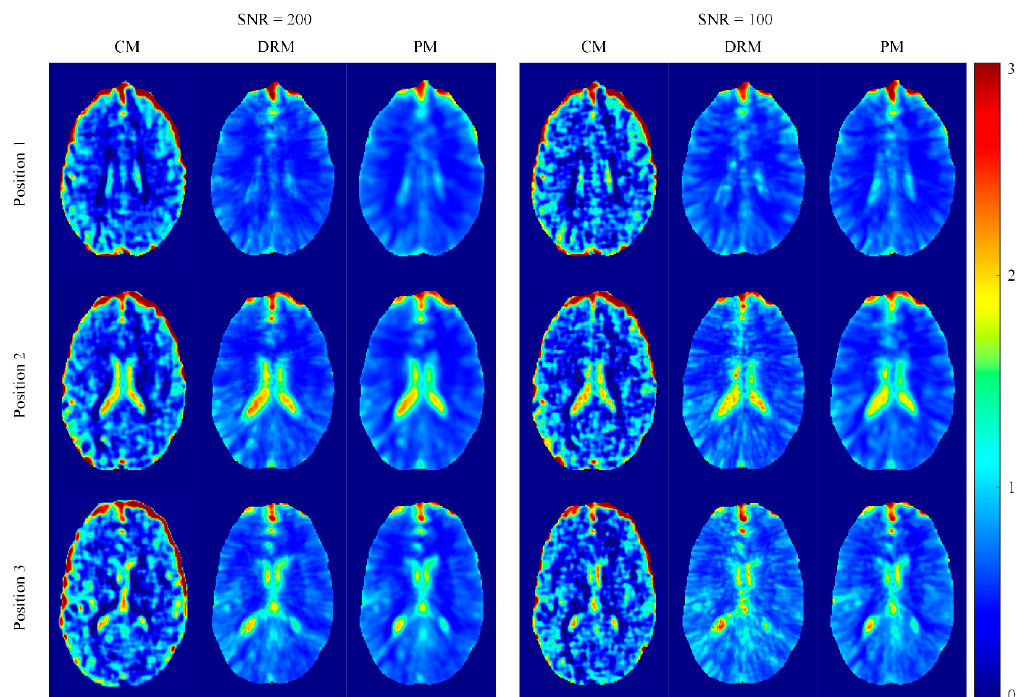
Figure 7. Reconstructed conductivity images of the Ella head model using the conventional method (CM), double regularization method (DRM) and proposed method (PM) under a signal to noise ratio (SNR) = 200 and SNR = 100.